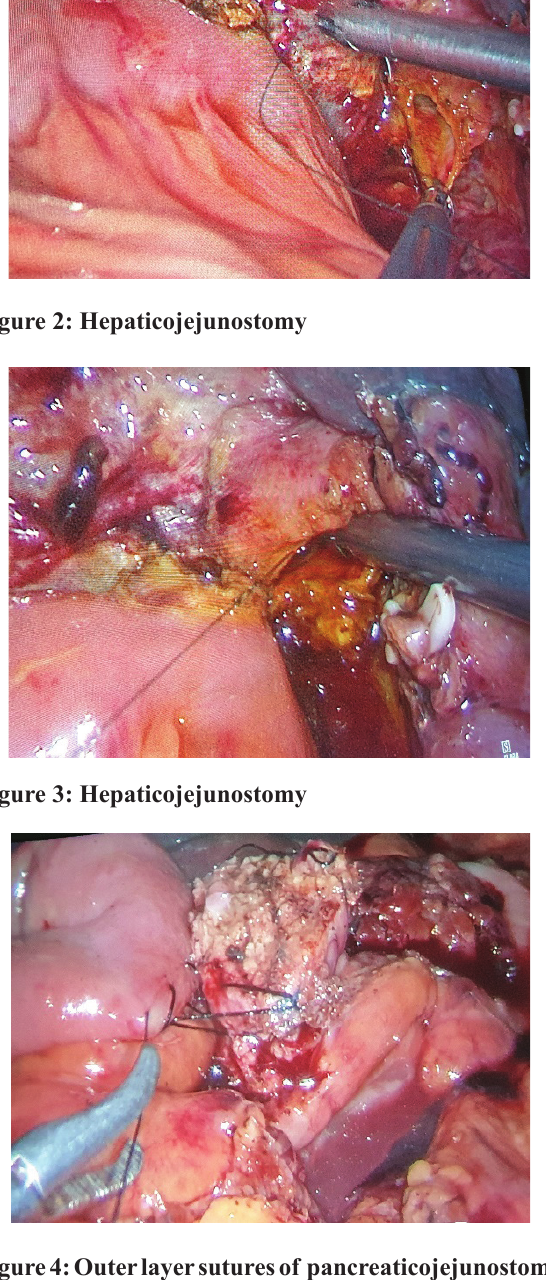
Figure 4: Outer layer sutures of pancreaticojejunostomy